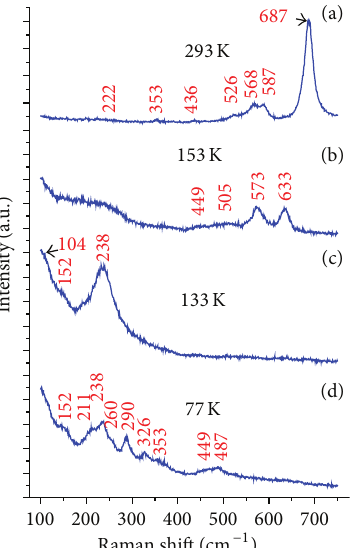
Figure 2: Raman spectra of the TlBa 2 Ca 2 Cu 3 O 9 high- 𝑇 𝐶 supercon- ductor films with Tl-1223 phase measured at different